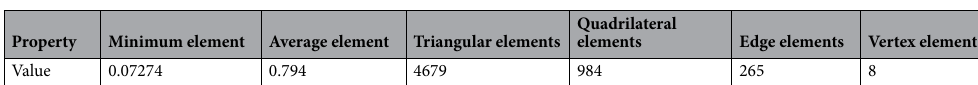
Table 2. Mesh descriptions during the finite element method over the domain of the flow 15 .